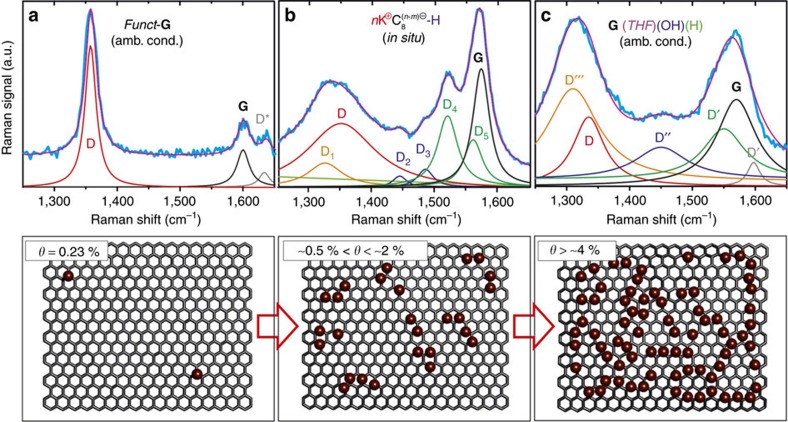
Evolution of Raman fingerprint with increasing DOF.(a) Hexyl functionalized graphene10 with isotropic distribution of functional groups with lateral DOF of LD>2 nm (θ<0.5%). (b) Local clustering of defect sites as observed in the in situ monitoring of the functionalization in a typical range of θ=0.5–2% using the precisely determined modes displayed in Fig. 1d. (c) Higher DOF (θ>2%) resulting in isolated sp2 domains surrounded by defect-rich sp3 regions.